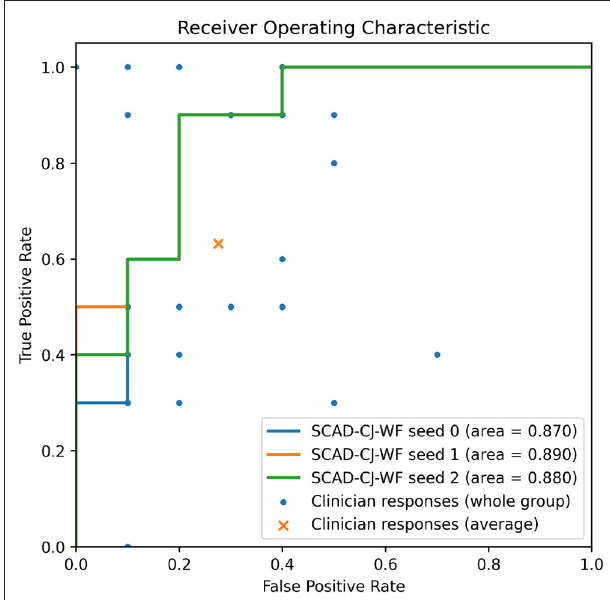
FIGURE 7 | Overlaying clinicians’ TPR/FPR samples ( n = 25) and group average on SCAD-CF-WF’s Receiver Operative Characteristic (ROC) curve. Multiple clinicians’ responses may have the same TPR/FPR